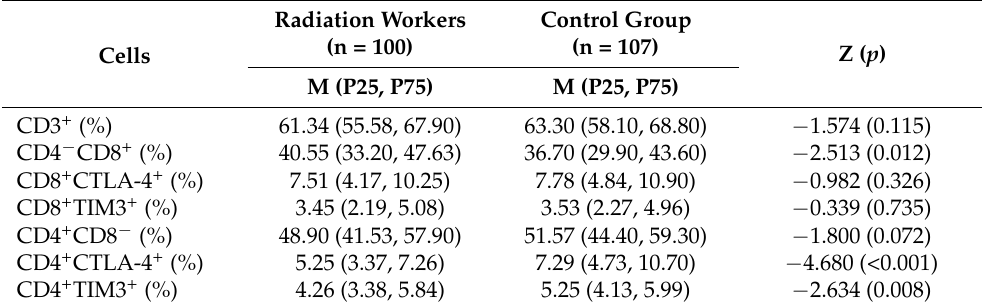
Table 3. Relative expression levels of CD3+, CD4+, and CD8+ cells and TIM-3 and CTLA-4 in